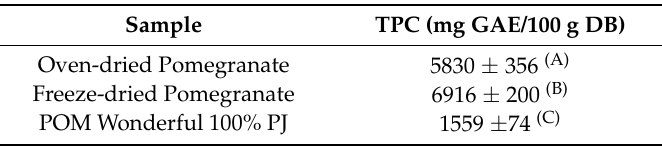
Table 2. Total phenol content for pomegranate samples per dry weight basis ⊥